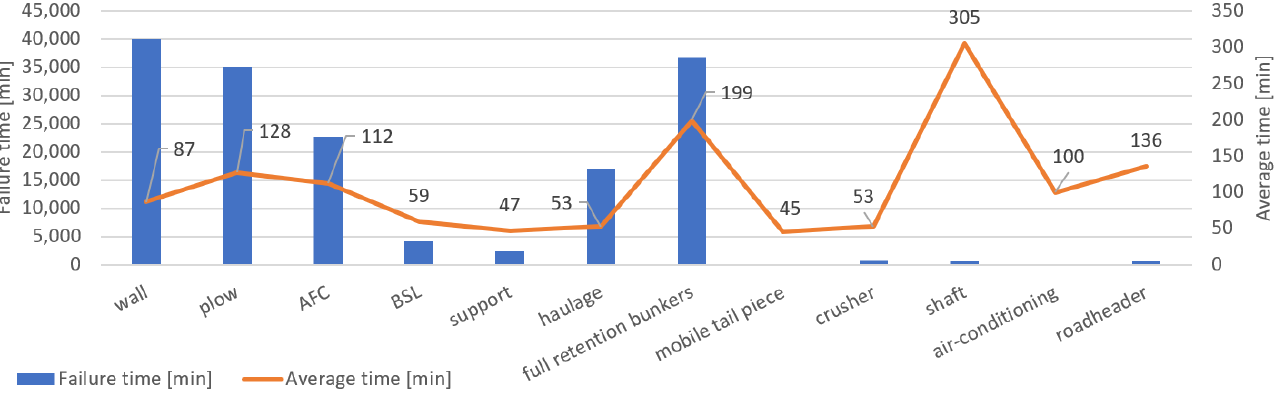
Figure 9. Duration of failures and average duration of failures of plow longwalls in total.